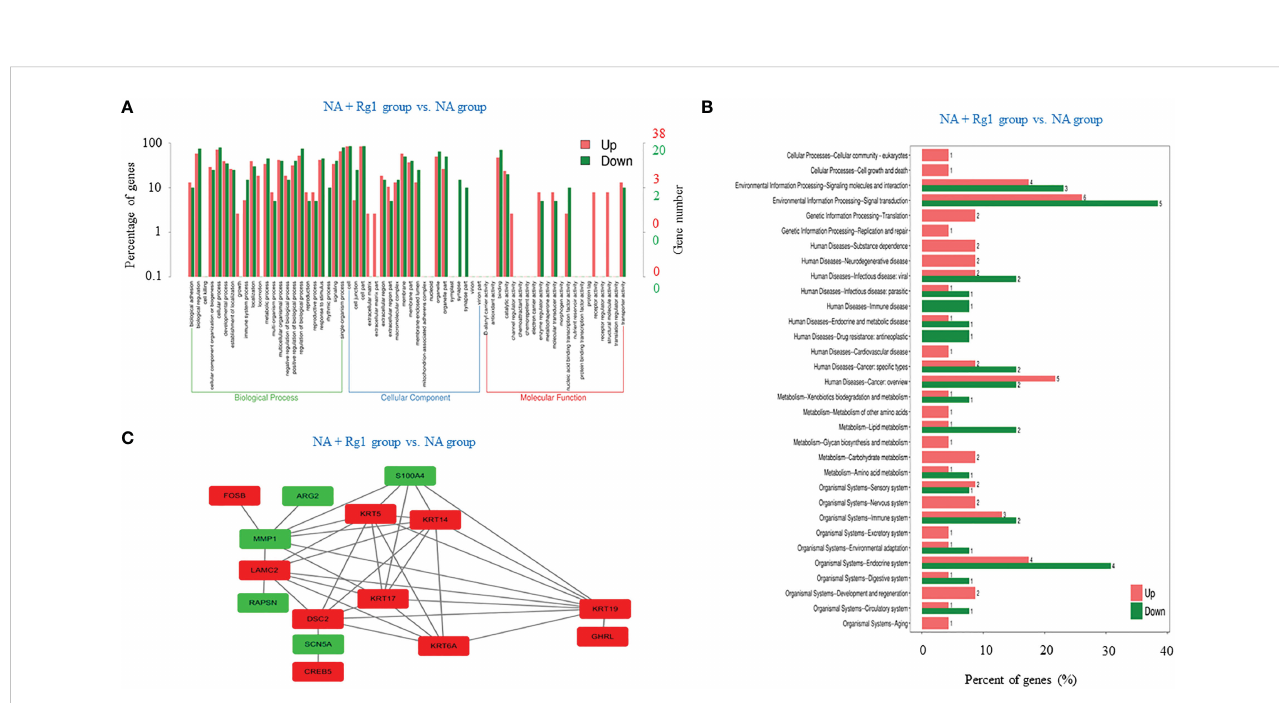
FIGURE 5 Correlation analysis of differentially expressed genes between the noradrenaline (NA) + Rg1 group and NA group. (A) Gene ontology (GO) enrichment of differentially expressed genes between the NA + Rg1 group and NA group. Three GO categories include biological process, cell component, and molecular function. Red represented upregulated genes, and green represented downregulated genes. (B) Kyoto Encyclopedia of Gene and Genomes (KEGG) analysis of differentially expressed genes between the NA + Rg1 group and NA group. Red represented upregulated genes, and green represented downregulated genes. (C) Predicted protein-protein interaction networks. Protein interaction networks that predicted 15 differential genes using the STRING database. Red represented upregulated genes, and green represented downregulated genes.